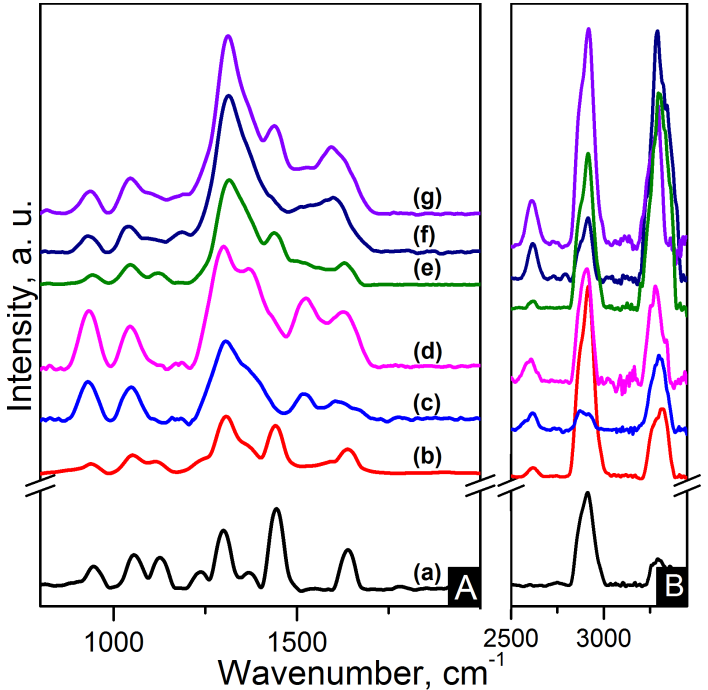
Figure 7. Raman spectra of the ( A ) 800–2000 cm − 1 region and ( B ) zoom-out of the 2800–3350 cm − 1 region of the samples: ( a ) pure PA66; ( b )